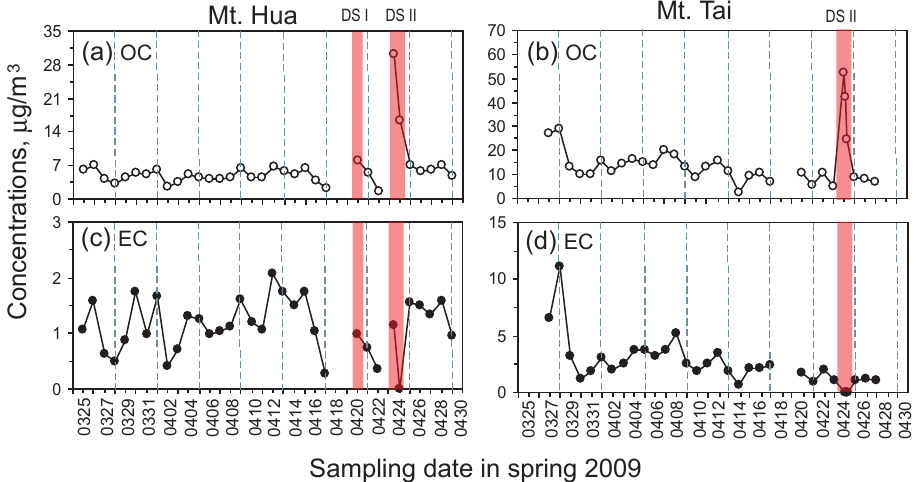
Fig. 3. Temporal variations of OC and EC in the PM 10 samples collected at Mt. Hua and Mt. Tai during the spring of 2009 (DS I and DS II: dust events).